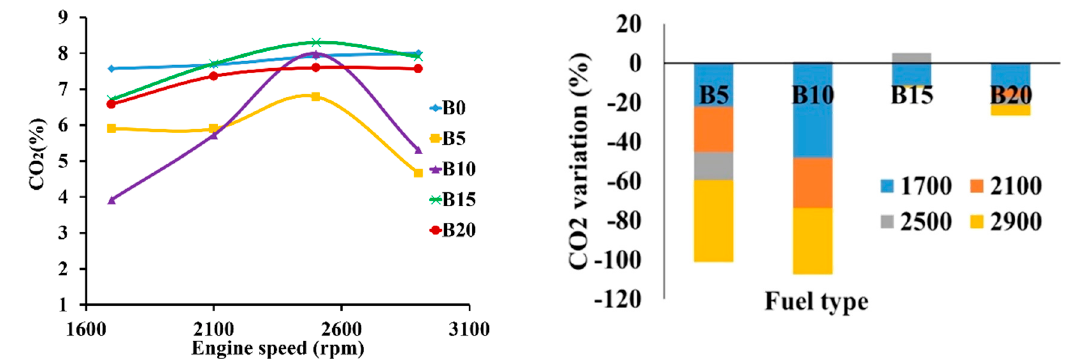
Figure 13. Variation of CO 2 (%) for different engine speeds and diesel biodiesel blends at full load.